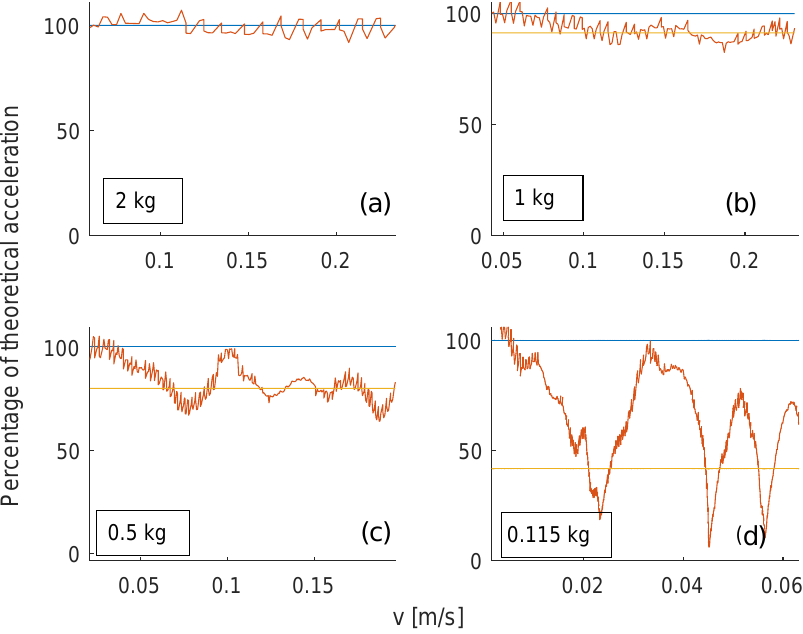
Figure 4. Acceleration measured and low pass filtered (orange) in relation to the theoretical acceleration (100%, blue line). The yellow line represents the value the measured acceleration tends to. Values are directly measured from the scale